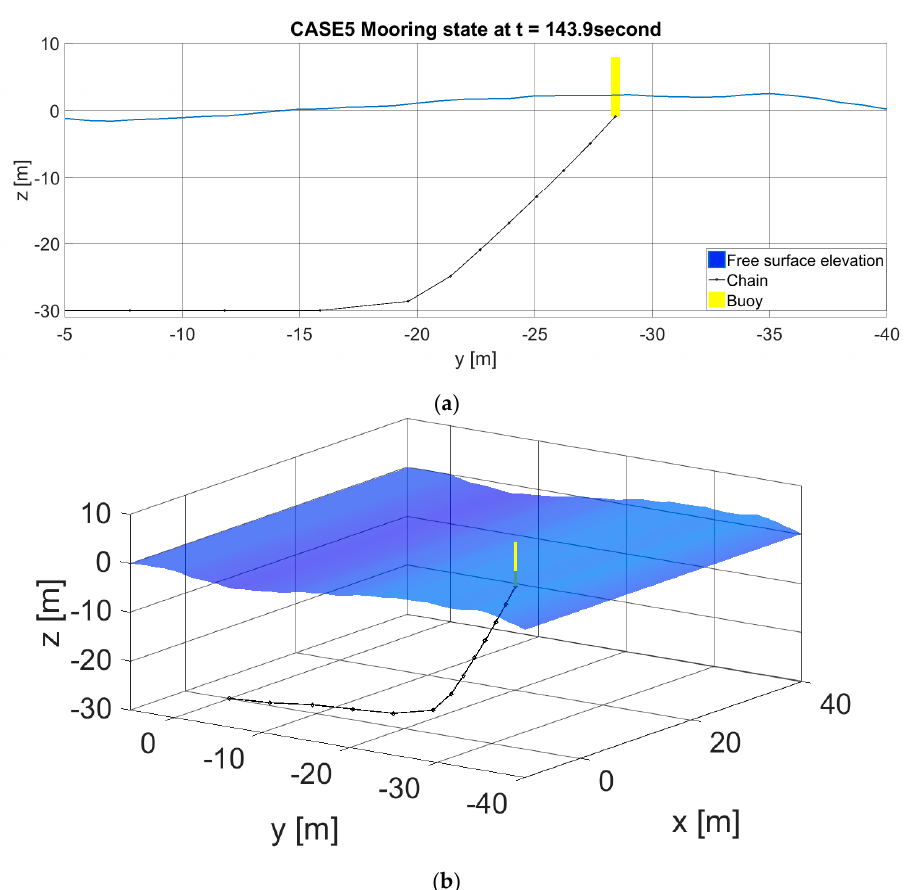
Figure 17. Simulation case 5: Mooring state at t = 143.9 in 2D ( a ) and in 3D ( b ) view. Flat bottom at z = − 30 m.